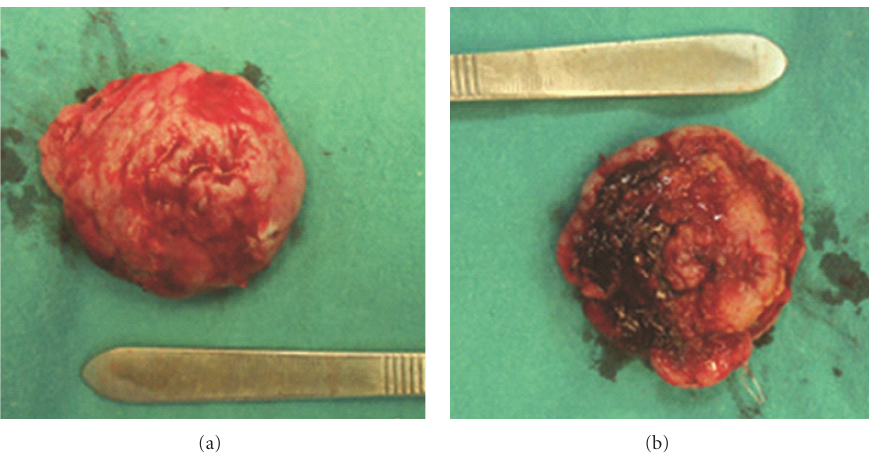
Figure 3: The macroscopic size of mass was measured 5.5 × 5.0 × 2.0 cm.